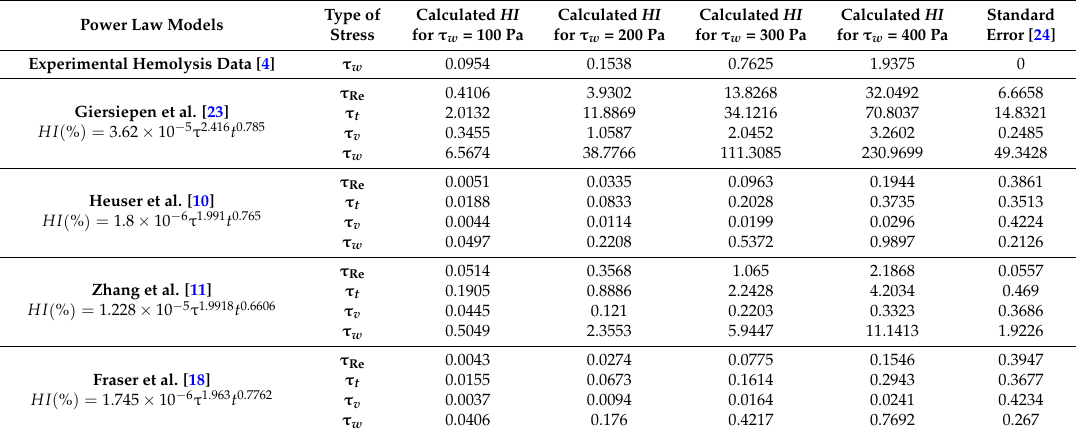
Table 4. Calculated Hemolysis Index ( HI ) applying four different and commonly used power law models and standard error when calculations are compared to experimental measurements by Kameneva et al. [4] 1